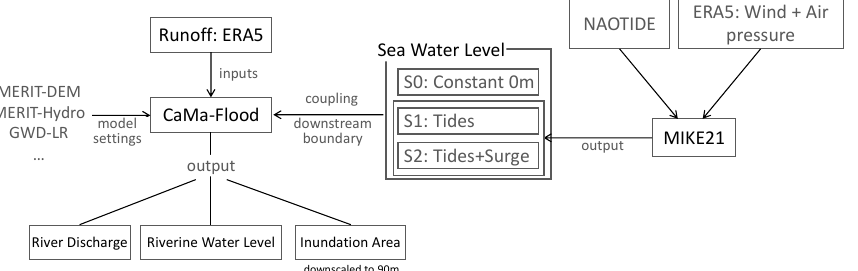
Figure 2. Flowchart of the research. Different sea water levels (S0, S1, S2) will be used as the downstream boundary of the global hydrodynamic model (CaMa-Flood). Among the various sea water level scenarios, S1 (tides) and S2 (tides + surge) were provided by simulations from ocean model MIKE21, with consideration of the tide boundary only, and inputs of tides, wind and air pressure. For details, please refer to Section 2.3.